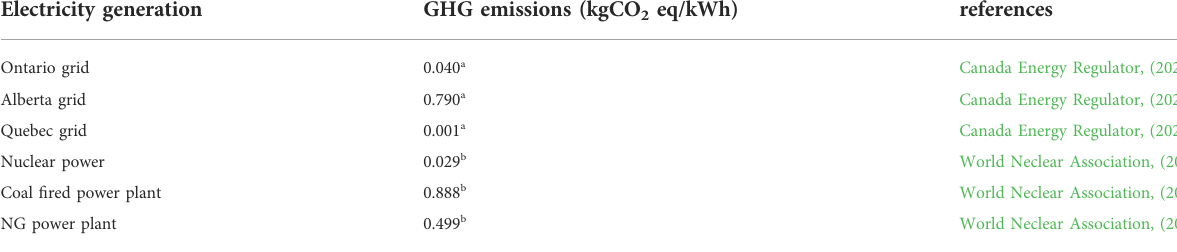
TABLE 1 Electricity generation routes studied in this work and their CO 2 eq emissions.